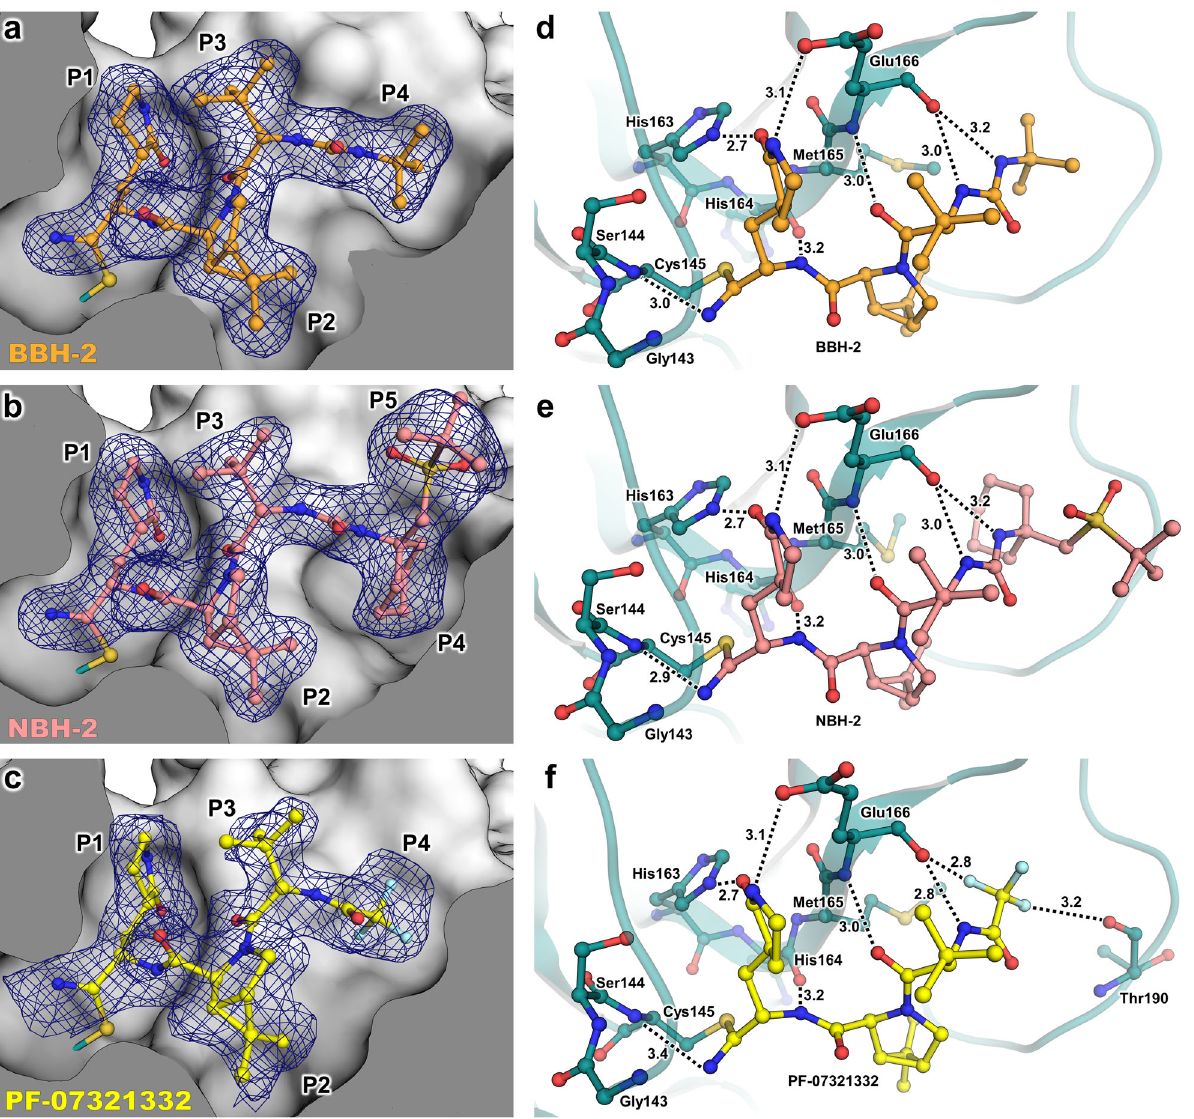
Fig. 4 Room-temperature X-ray crystal structures of M pro in complex with nitrile warhead inhibitors BBH-2, NBH-2, and PF-037321332. a – c Inhibitors BBH-2, NBH-2, and PF-037321332 bind to the active site of M pro and form a covalent thioimidate with Cys145. Polder omits maps of inhibitor atoms (blue mesh) contoured to 3 σ . d – f Hydrogen bonds between inhibitors and M pro are shown as black dashes with distances in angstroms